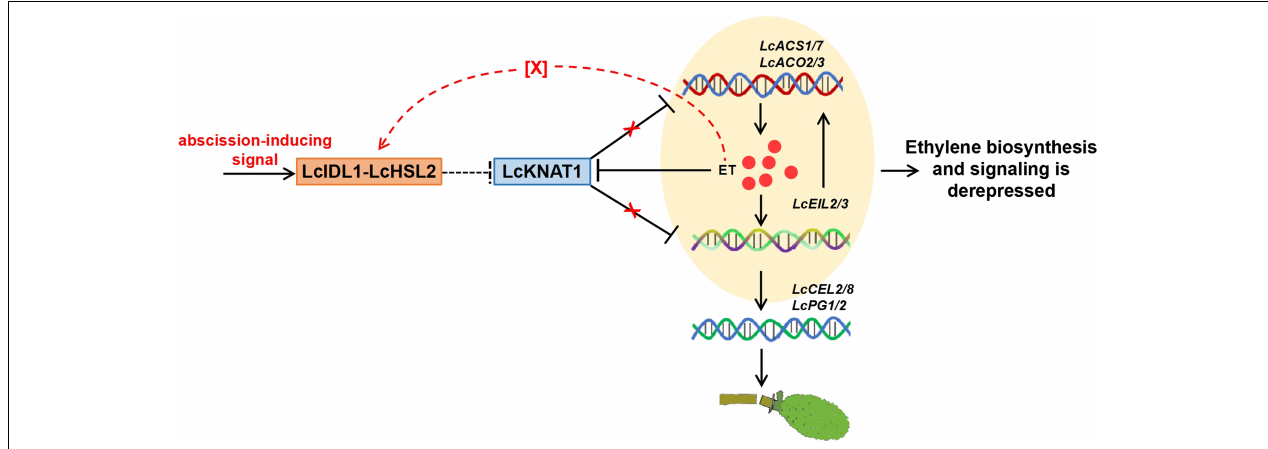
FIGURE 7 | Proposed model for the role of LcKNAT1 in ethylene (ET)-regulated fruitlet abscission in litchi. LcKNAT1 can directly repress LcACS1 / 7 , LcACO2 / 3 , and LcEIL2 / 3 , when LcKNAT1 is repressed by unknown abscission-inducing signals LcACS1 / 7 and LcEIL2 / 3 which are derepressed. Furthermore, LcEIL2/3 can also bind to LcACS1 / 7 and LcACO2 / 3 but promote their transcription, therefore forming a feedback loop to enhance the ET biosynthesis and signaling. Additionally, ET could also disable the repressor function of LcKNAT1 through the indirect activation of the LcIDL1-LcHSL2 module via an unknown factor, thereby enhancing the activation of the cell wall degradation genes LcCEL2 / 8 and LcPG1 / 2 to induce fruitlet abscission.